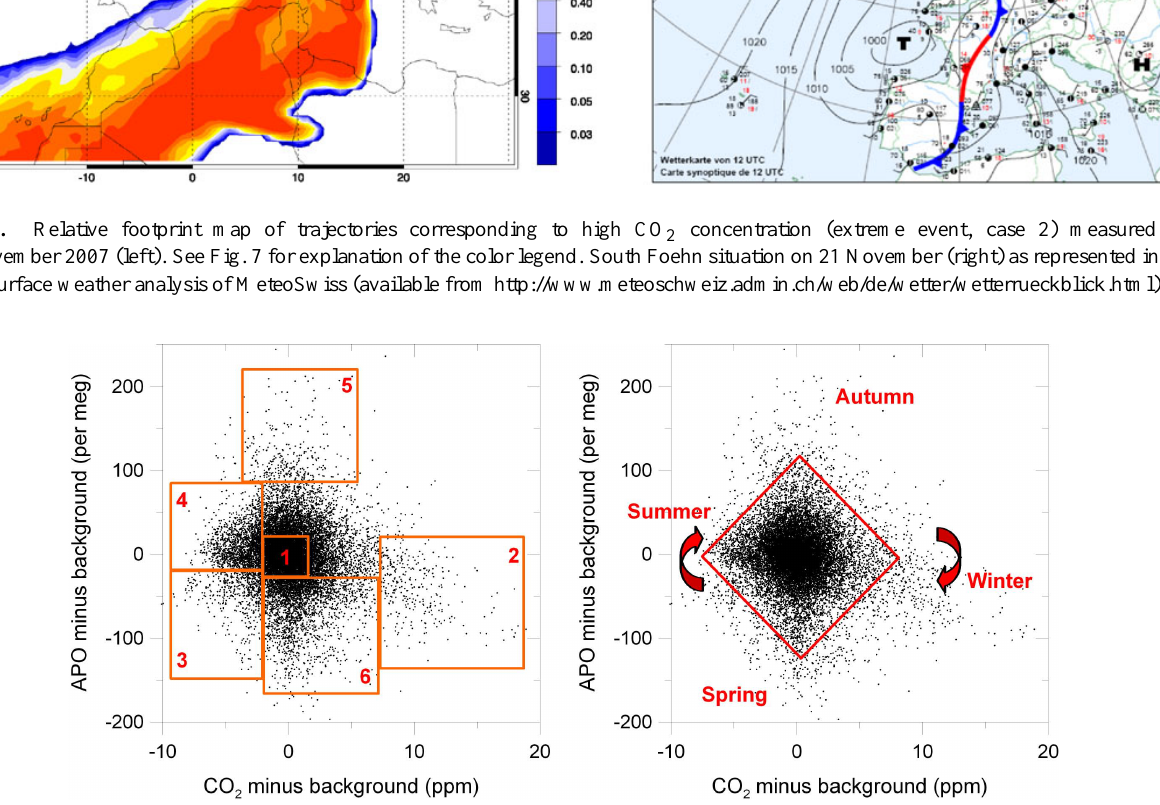
Fig. 9. Different selections (see text for explanations) in the scatter plot of the background corrected APO versus background corrected CO 2 (left panel). Seasonal cycle of defined subsets (right